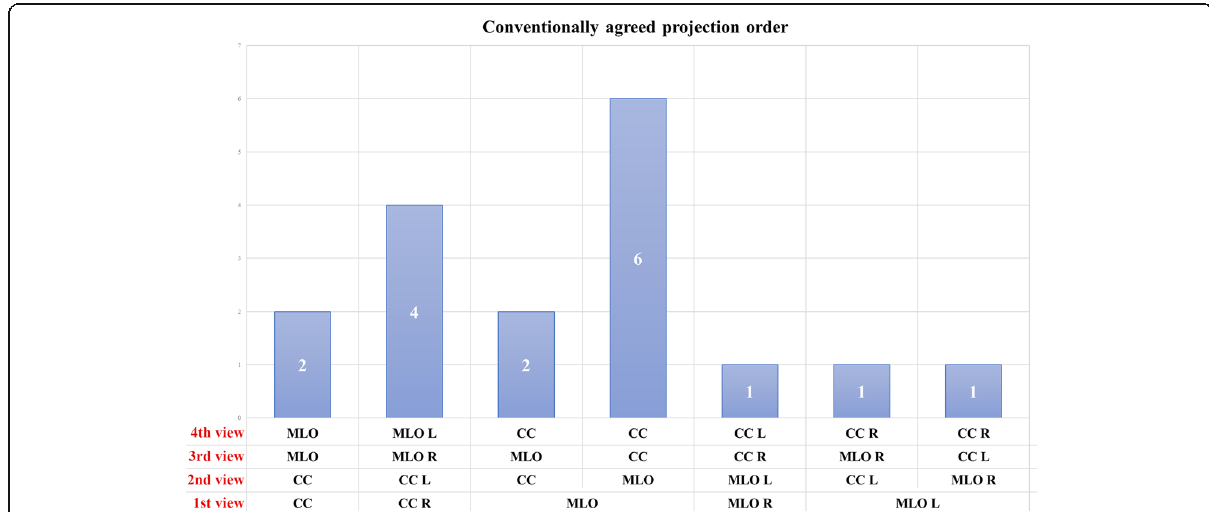
Fig. 3 Graphical summary of conventionally agreed view acquisition orders for contrast-enhanced spectral mammography: CC craniocaudal view, MLO mediolateral oblique view, L left, R right